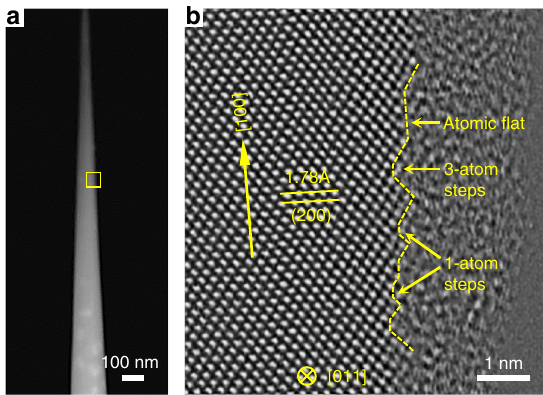
Fig. 1 Characterization of a <100> diamond nanoneedle. a A low-magnitude high-angle annular dark- fi eld scanning TEM (HAADF-STEM) image of a diamond nanoneedle after fabrication. The needle axis is parallel to [100]. b Atomically resolved annular bright- fi eld scanning TEM (ABF-STEM) image of the free surface as marked by the yellow box in a